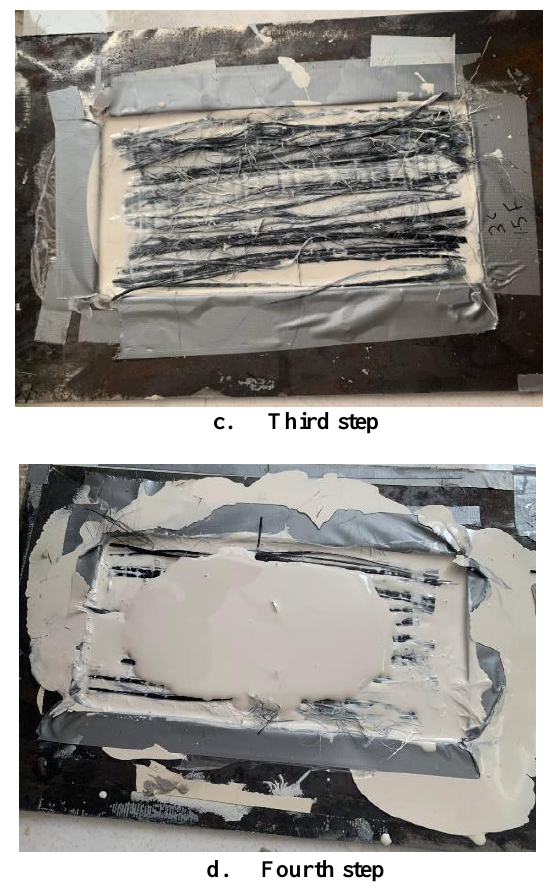
Fig. 4 steps of fabricating composite